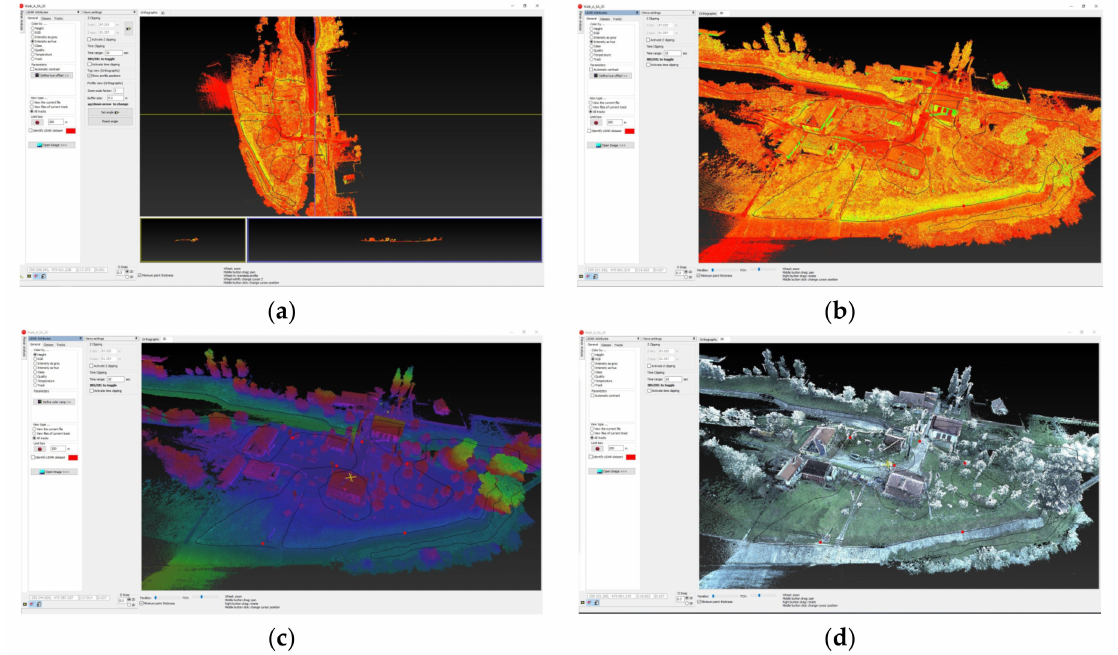
Figure 31. Cos teiu Hydrotechnical Node, Timis , Romania, scan performed on 15 May 2019: ( a ) The , , intensity of the LiDAR data nuance, the orthographic visualization; ( b ) The nuance intensity of the LiDAR data, 3D visualization; ( c ) LiDAR data coloured by altitude; ( d ) View point clouds (RGB).